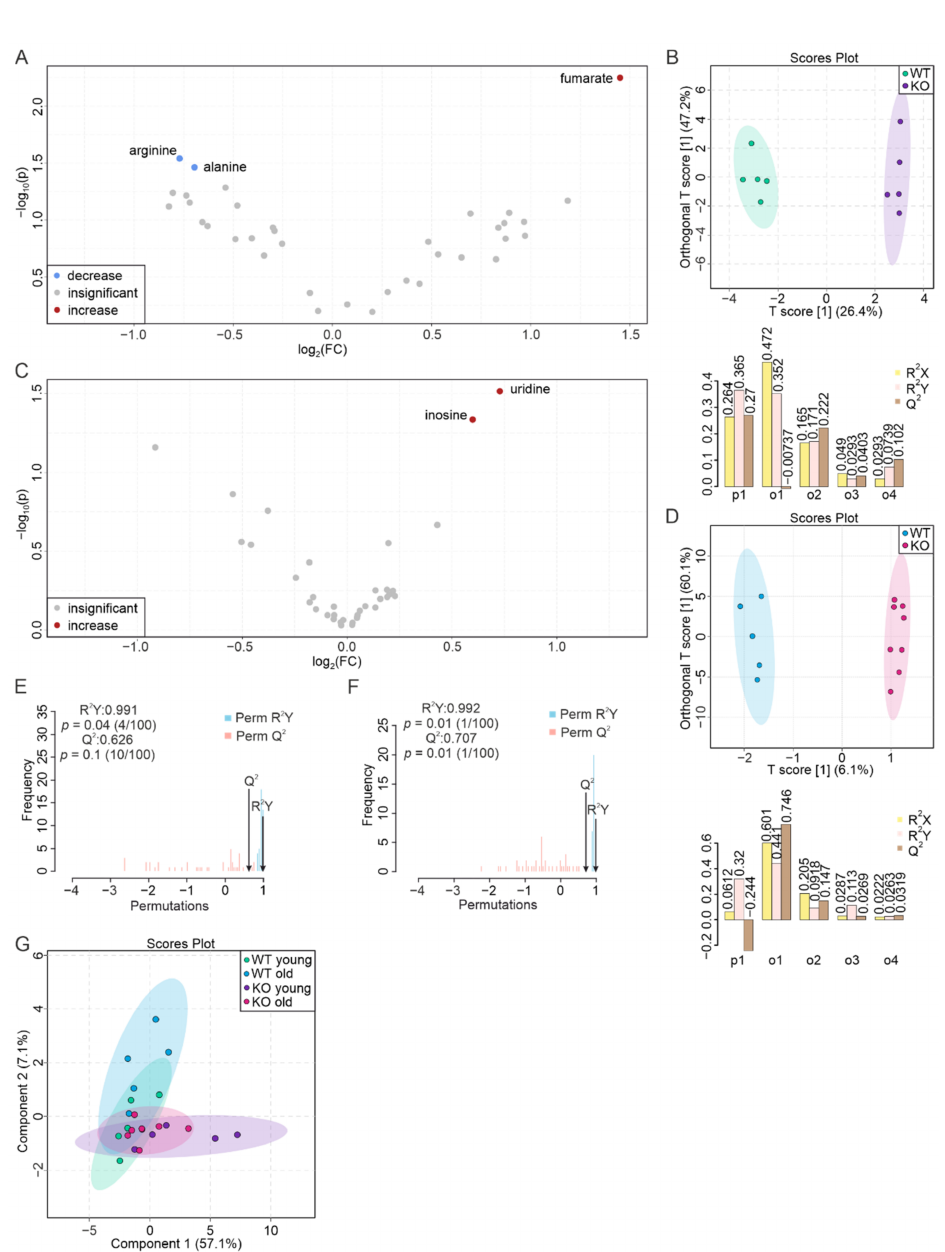
Figure 7. Jejunal metabolites are hardly affected by ageing or PEMT deficiency. ( A ) Volcano plot showing differences in the metabolic profiles of WT and PEMT KO jejuna from young mice. Red and blue corresponds to significantly increased and decreased metabolites, respectively. Grey dots correspond to metabolites with insignificant changes. ( B ) O-PLS-DA plot of WT ( n = 5, green) and KO ( n = 5, purple) jejunum samples from young mice (upper panel), and model quality assessment for p1 and four orthogonal components (o1, o2, o3, and o4) with cross-validation coefficients R 2 X, R 2 Y, and Q 2 (lower panel). ( C ) Volcano plot showing differences in the metabolic profiles of WT and PEMT KO jejuna from aged mice. Red dots represent significantly increased metabolites. Grey dots denote metabolites with insignificant changes. ( D ) O-PLS-DA plot of WT ( n = 5, blue) and KO ( n = 8, pink) jejunum samples from aged mice (upper panel), and model quality assessment for p1 and four orthogonal components (o1, o2, o3, and o4) with cross-validation coefficients R 2 X, R 2 Y, and Q 2 (lower panel). ( E ) Histogram showing permutation test of samples in ( B ) and ( F ) of samples in ( D ) with permutation number n = 100, respectively. ( G ) S-PLS-DA plot of the 4 jejunum groups, with green, purple, blue, and pink corresponding to WT young, KO young, WT old, and KO old,